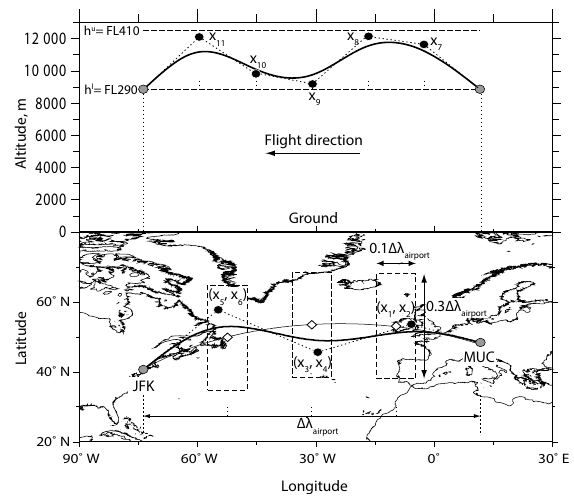
Figure 6. Geometry definition of flight trajectory in the verti- cal cross section (top) and projection on the Earth (bottom). The bold solid line indicates a trajectory from MUC to JFK. • : control points determined by design variables x = (x 1 ,x 2 , ··· ,x 11 ) T . The lower/upper bounds of the 11 design variables are shown in Table 6. Bottom: the dashed boxes show rectangular domains of three con- trol points. : central points of the domains are calculated on the great circle (thin solid line), which divide the (cid:49)λ airport into four (cid:51) equal parts. Top: the dashed lines show the lower/upper variable bounds in altitude. “FL290” stands for a flight level at 29000ft. Longitude coordinates for x 7 ,x 8 , ··· ,x 11 are pre-calculated; the co- ordinates divide the (cid:49)λ airport into six equal